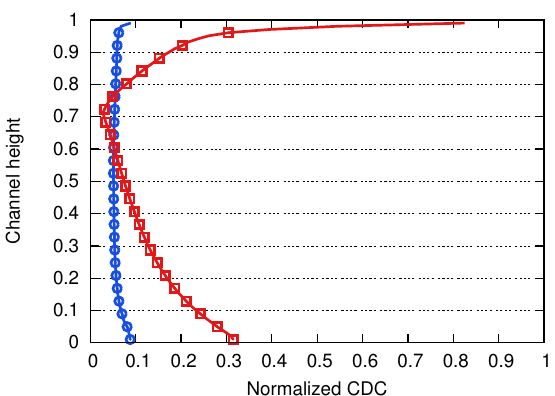
Figure 12. Radial evolution of the CDC in a plane right upstream of the fan: axisymmetric air inlet in blue line marked with circles and asymmetric air inlet in red line marked with squares.